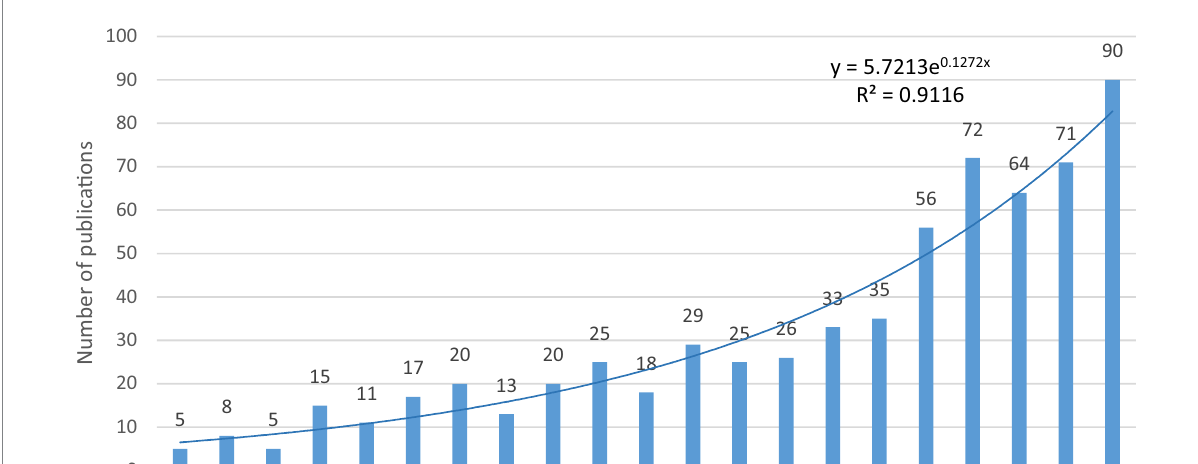
FIGURE 1 The combination chart of the number of annual publications.